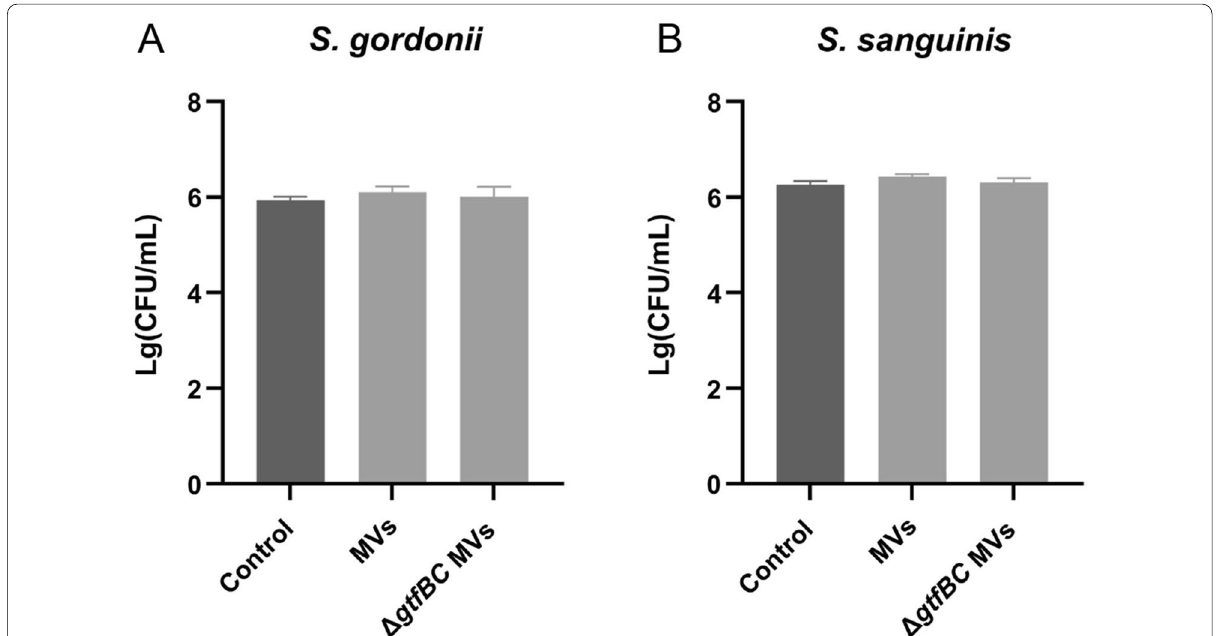
Fig. 3 Effects of MVs on the planktonic growth of S. gordonii and S. sanguinis . A CFU counts of S. gordonii in the presence or absence of S. mutans MVs or S. mutans Δ gtfBC mutant MVs. B CFU counts of S. sanguinis in the presence or absence of S. mutans MVs or S. mutans Δ gtfBC mutant MVs. There were no significant differences among the groups. The data are presented as mean